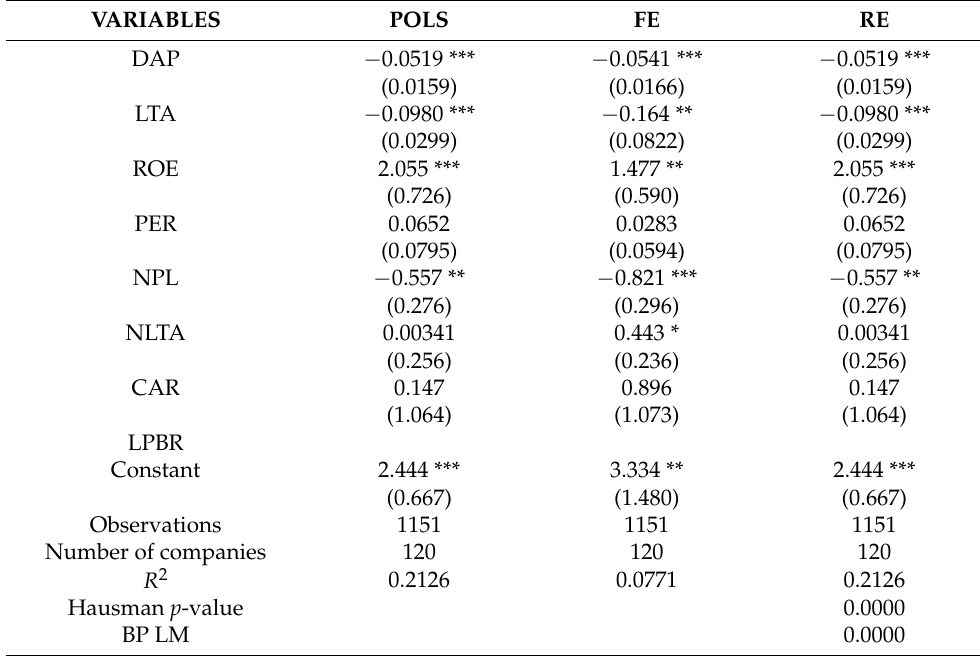
Table A2. Results of the regressions when using other